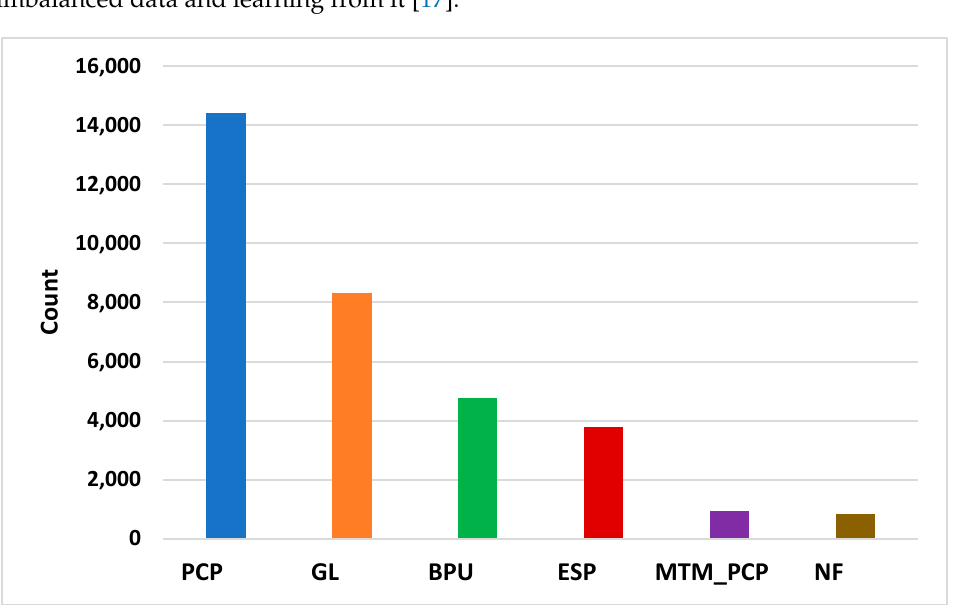
Figure 1. Muglad basin modi fi ed from [13], the selected fi eld is the upper block.